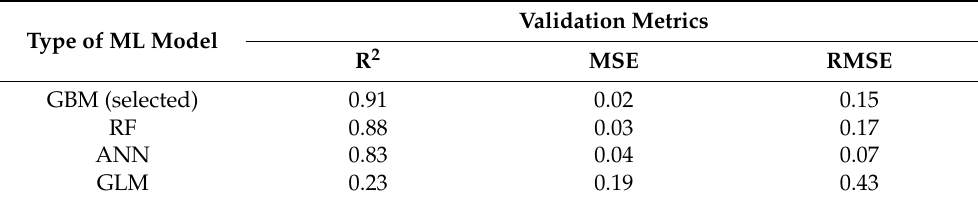
Table 5. Selection metrics for the implementation